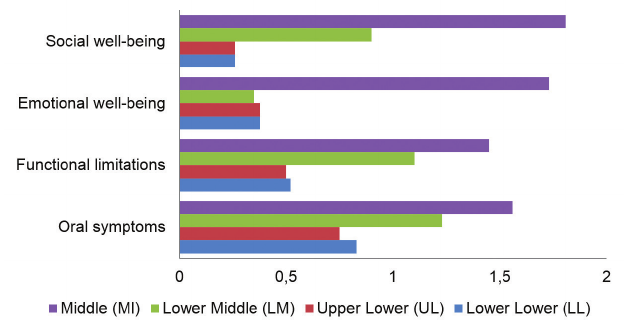
Fig.1. Relationship between the subscales of P-CPQ Index and socioeconomic classes, Américo de Campos/Pontes Gestal, Brazil, 2015.